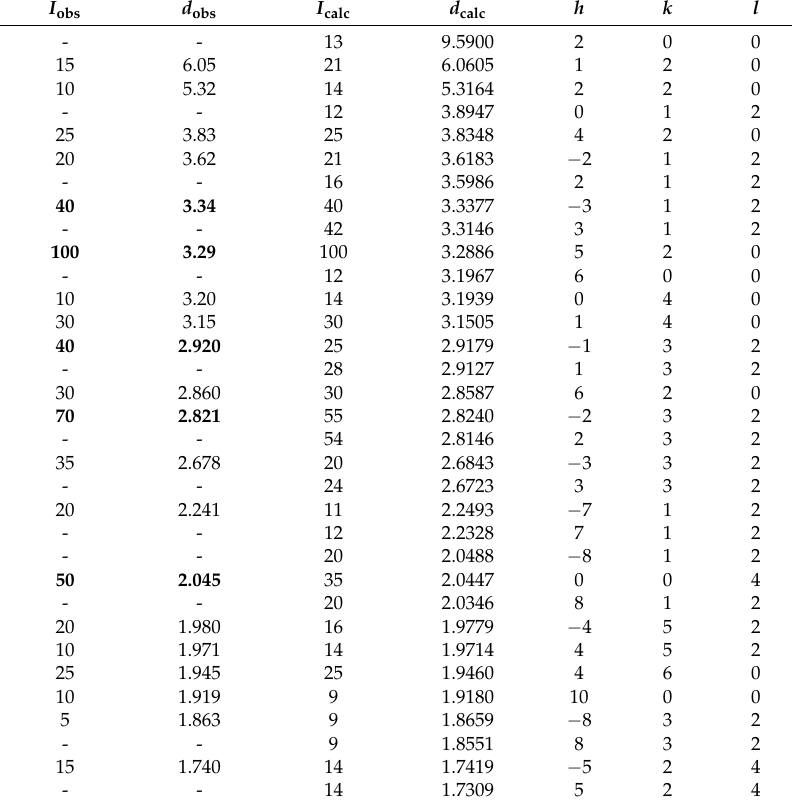
Table 6. Observed and calculated X-ray powder diffraction data ( d in Å) for oyonite. The five strongest reflections are given in bold.